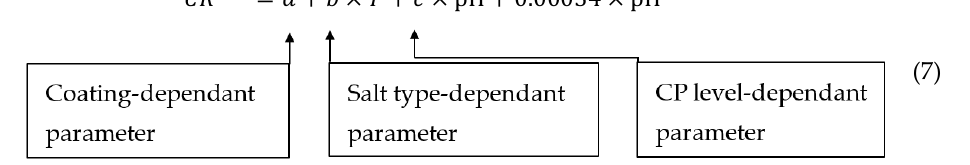
Table 4. The coefficients in the established mathematical